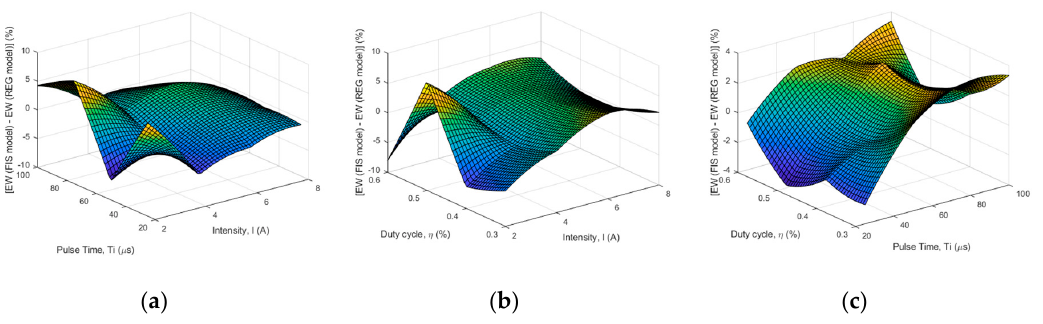
Figure 6. Difference between EW (FIS model) and EW (regression [2]) vs.: ( a ) Pulse Time and Intensity; ( b ) Duty cycle and Intensity; ( c ) Duty cycle and Pulse Time.